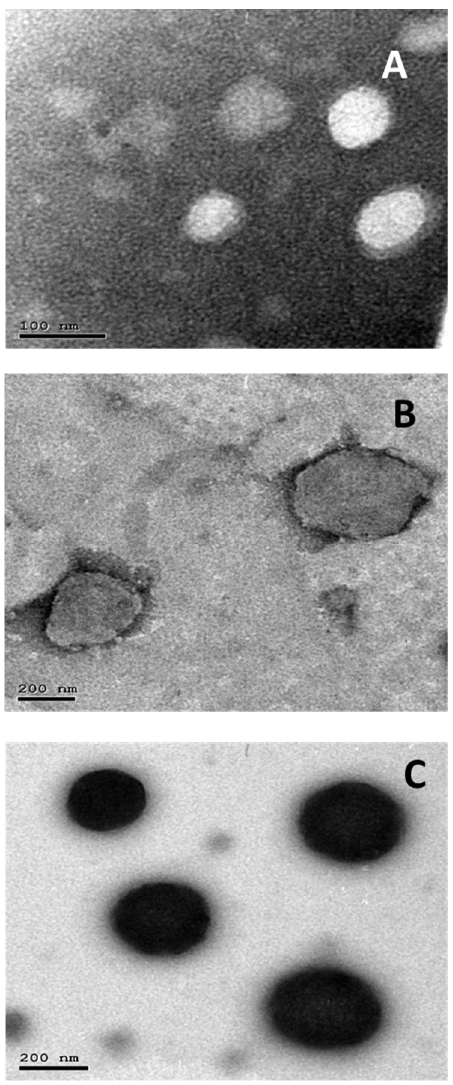
Figure 2. TEM micrographs of: ( A ) plain EMLs, ( B ) LEF loaded EMLs, and ( C ) LEF SPION EMLs.